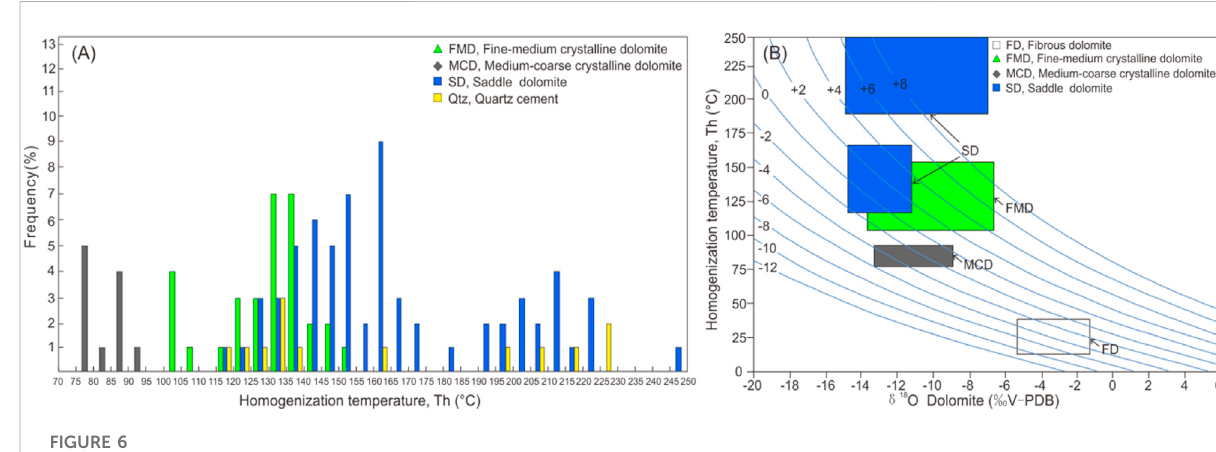
FIGURE 6 (A) Homogenization temperature (Th) distribution of fl uid inclusions for different rock fabrics in the Dengying Formation of Central Sichuan Basin and surrounding area (all the Th data are from Feng et al., 2017; Peng J. et al., 2018; Gu et al., 2019; Zhou et al., 2020; Su et al., 2022). (B) Crossplot of δ 18 O and precipitation temperature for different dolomite fabrics in the Dengying Formation of Central Sichuan Basin and surrounding area (all the Th data are from Feng et al., 2017; Peng B. et al., 2018; Gu et al., 2019; Zhou et al., 2020; Su et al., 2022). The δ 18 O (V-SMOW) of dolomite parent fl uids was calculated using the equation proposed by Land (1983).